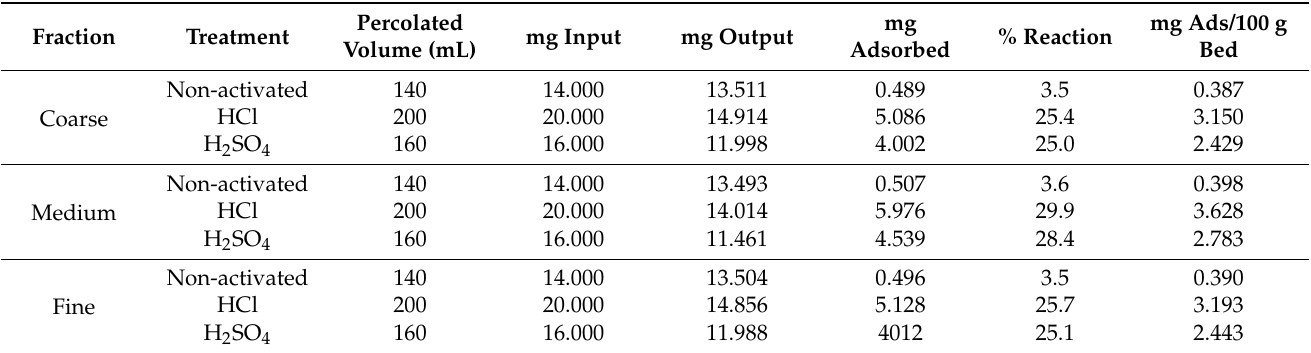
Table 3. Mass-balance of phosphate in the column experiments with the substrates treated with both HCl and H 2 SO 4